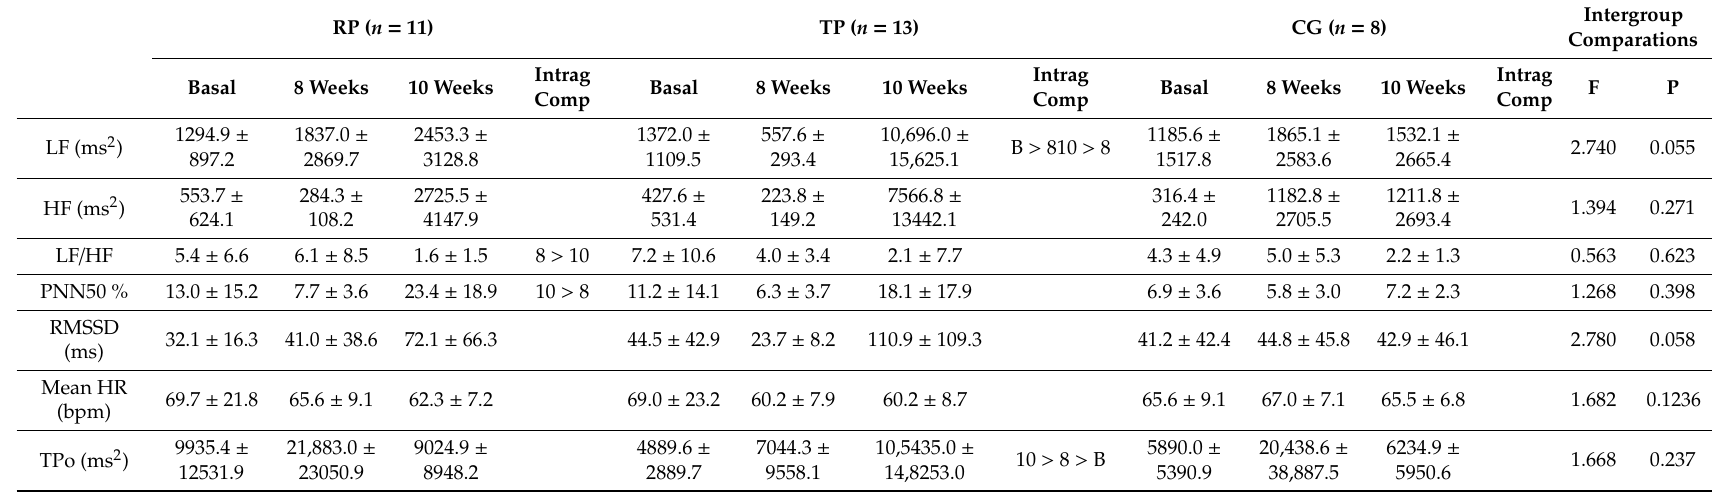
Table 3. Heart rate variability values before, after 8 weeks of training, and after two weeks of tapering in the three groups, mean ±